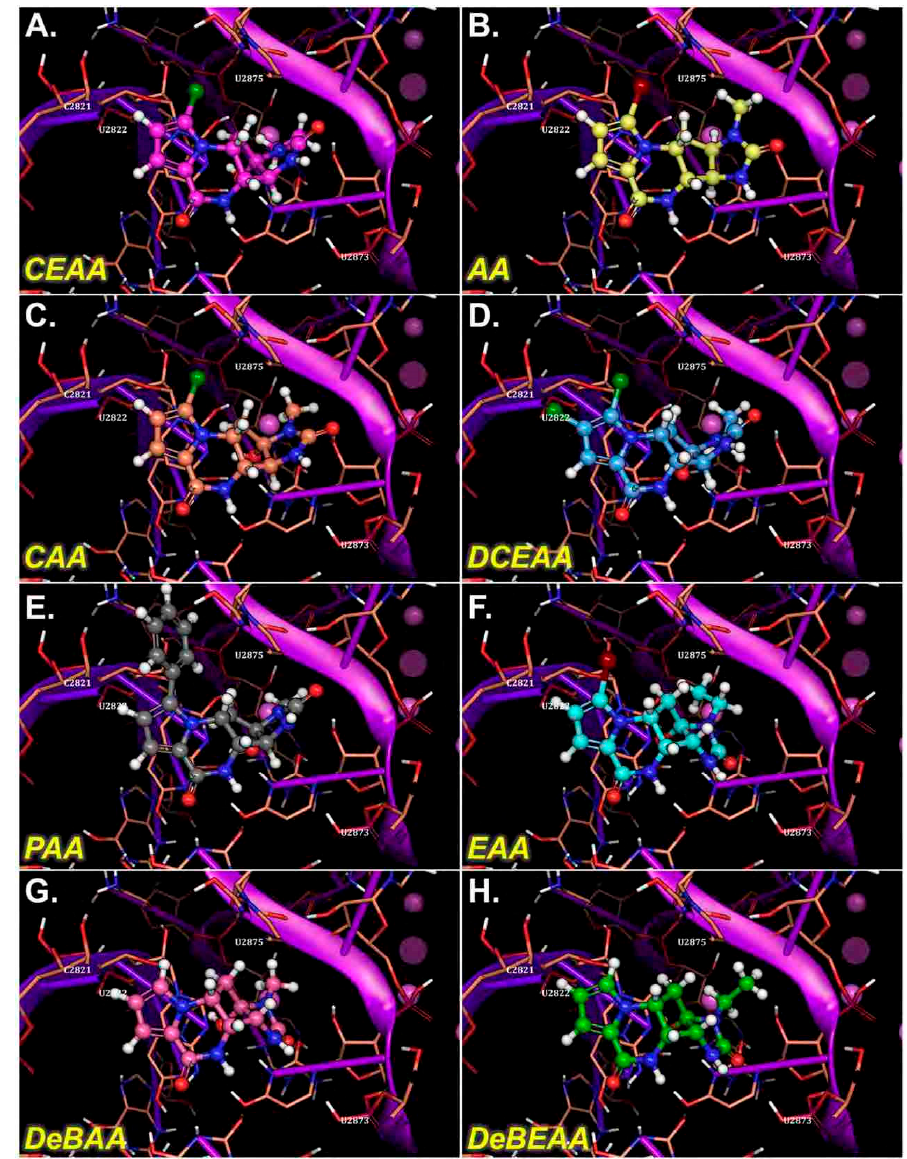
Figure 4. Three-dimensional docked images for AA, CAA, CEAA, EAA, PAA, DCEAA, DeBAA, and DeBEAA with ribosome’s PTC region (prior to Molecular Mechanics-Generalized-Born Solvent Accessible (MM-GBSA) energy calculations). Docking assigns the compounds pose or position in the PTC. The potent derivatives, CEAA, AA, DCEAA and CAA have a similar orientation in their binding and other less potent derivatives lack matching overlap. As the docking is machine driven to the optimal score possible and alternative positions drop with increasingly positive scores, these orientations illustrate the effect subtle changes have on compound efficacy and orientation. Here, the relevant interactions between ribosome and the AA that form important binding sites are shown. ( A ) AA is shown bound in the ribosomal PTC, which has good docking pose that matches the X-ray structure (see two-dimensional ligand interaction map for details on binding residues). ( B ) CEAA shows the critical residues needed for binding to PTC. ( C ) DCEAA is shown with the PTC region surrounding. ( D ) CAA has some similar binding characteristics to that of AA on the PTC. ( E ) PAA is given as bound in the ribosome. ( F ) EAA has weak binding in the PTC. ( G ) DeBAA is shown docked into PTC. ( H ) DeBEAA has weak binding at the